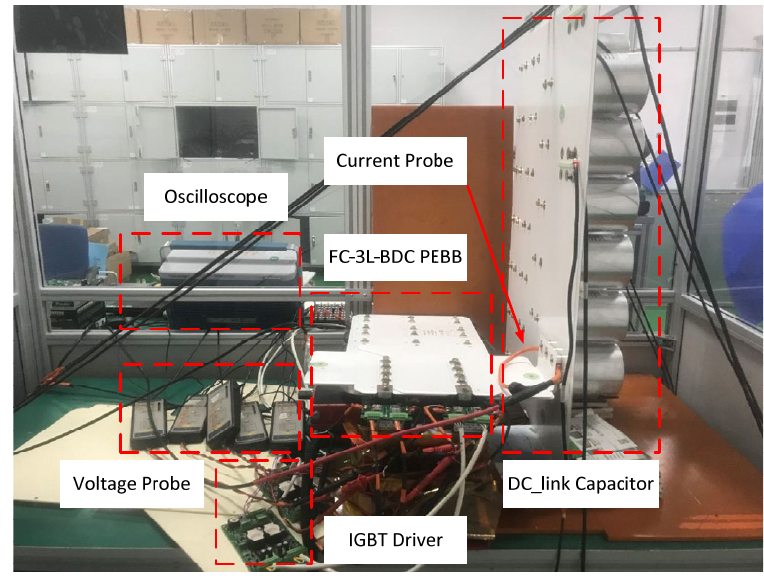
Figure 16. Photograph of the test bench.